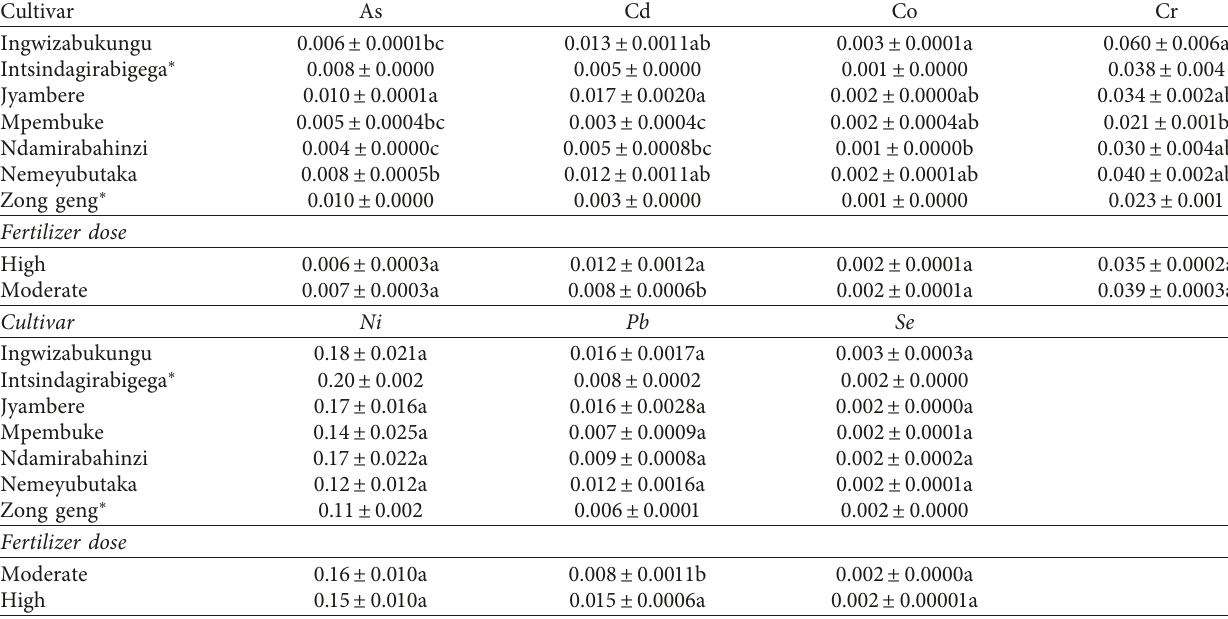
Table 3: Heavy metal content (mg · kg − 1 dry weight) (10) in Rwandan rice cultivars.